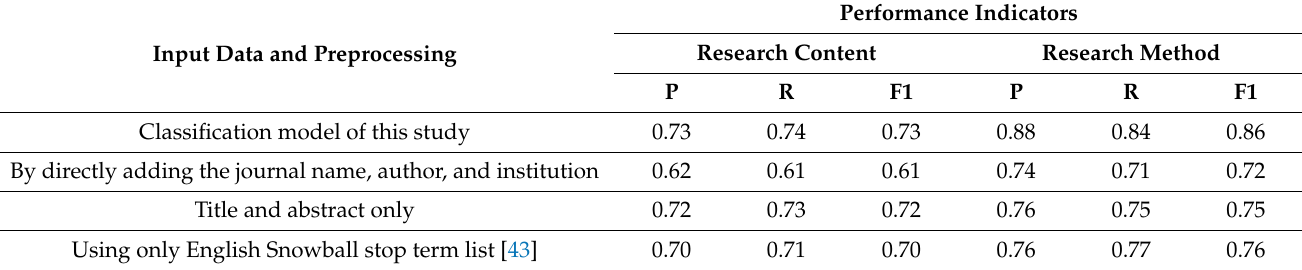
Table 8. Comparison of data science and analytics literature topic classification results with different data inputs and